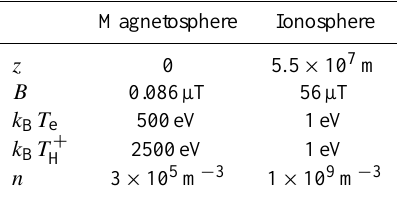
Table 2. Parameters used in the